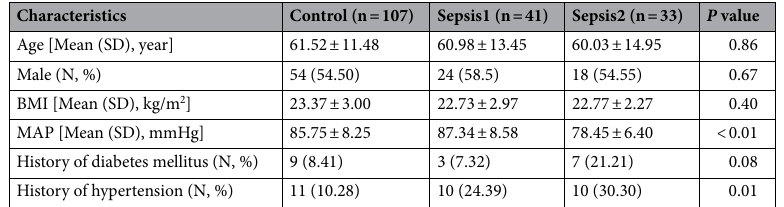
Table 1. General characteristics in three groups. The data of categorical variables are presented as N (%), and the data of continuous variables are presented as mean ±